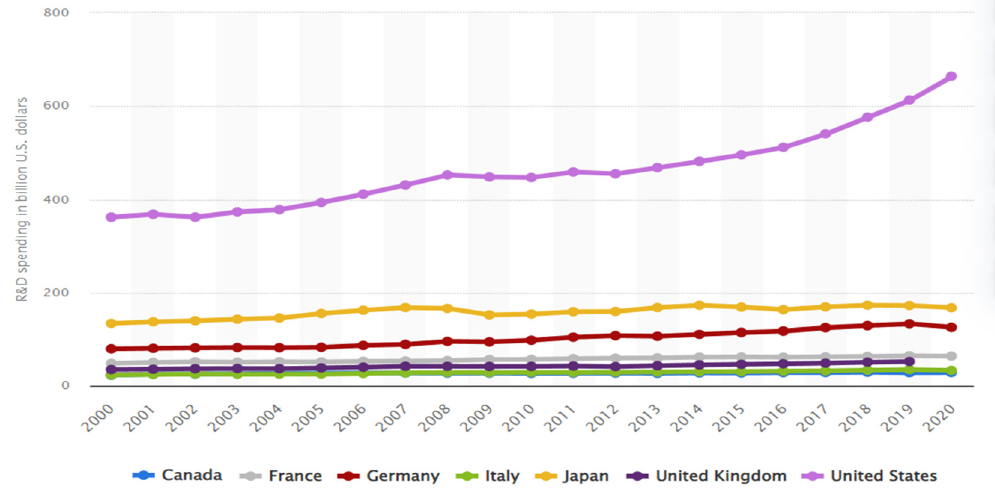
Figure 1 . R&D trend in G7 economies (source: Statista 2020). Figure 1. R&D trend in G7 economies (source: Statista